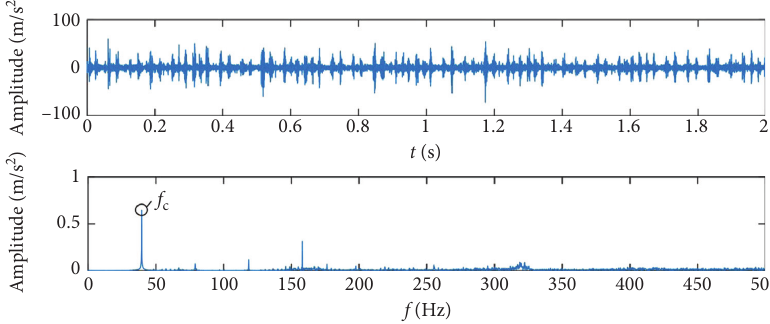
Figure 19: Signal processed by is relatively c